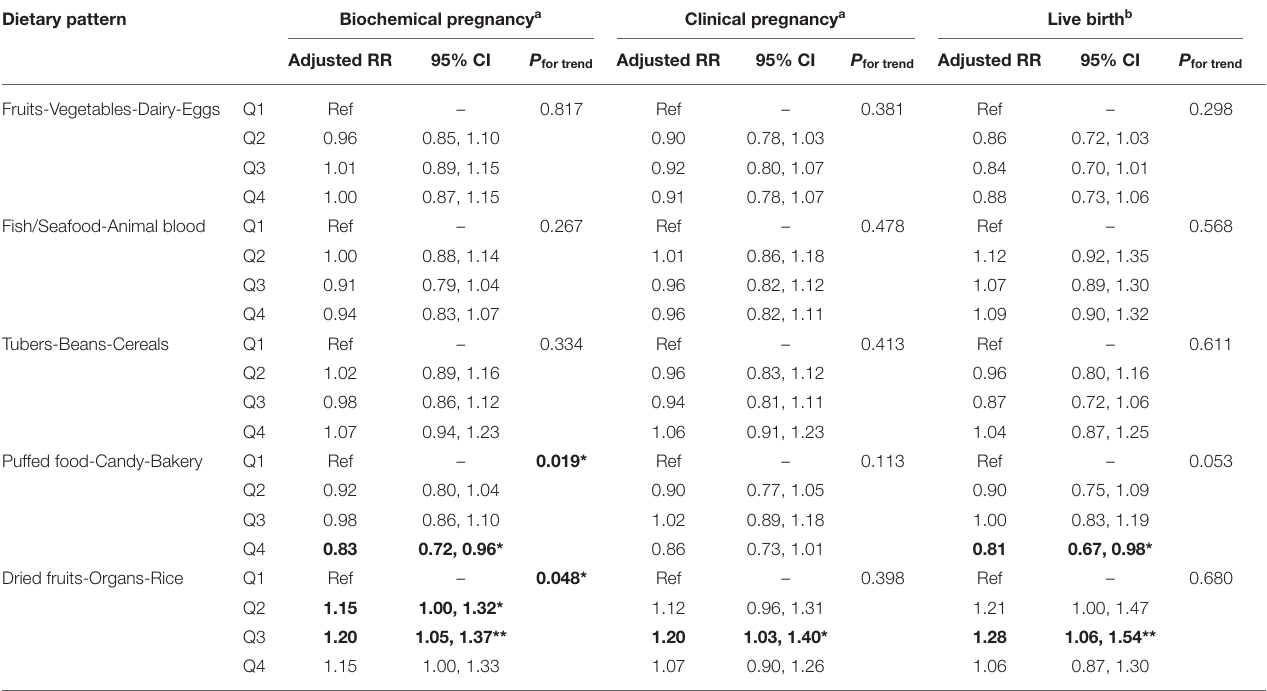
TABLE 5 | Associations of the dietary patterns derived by principal component analysis with biochemical pregnancy, clinical pregnancy, and live birth. Dietary